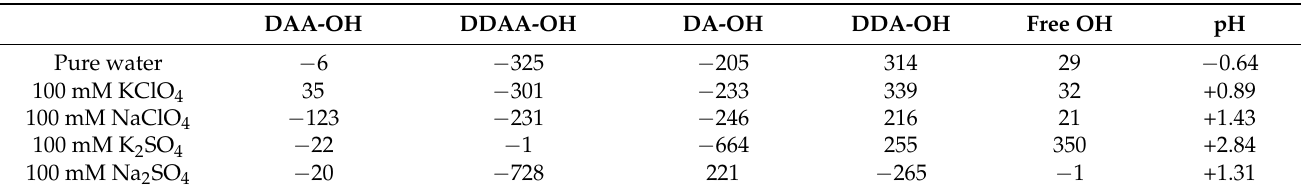
Table 1. Slopes of lines fitted to the amplitudes of the Gaussians from the deconvolution of the Raman spectra of water and pH change, 100 mM aqueous solutions of KClO 4 , NaClO 4 , K 2 SO 4 , and Na 2 SO 4